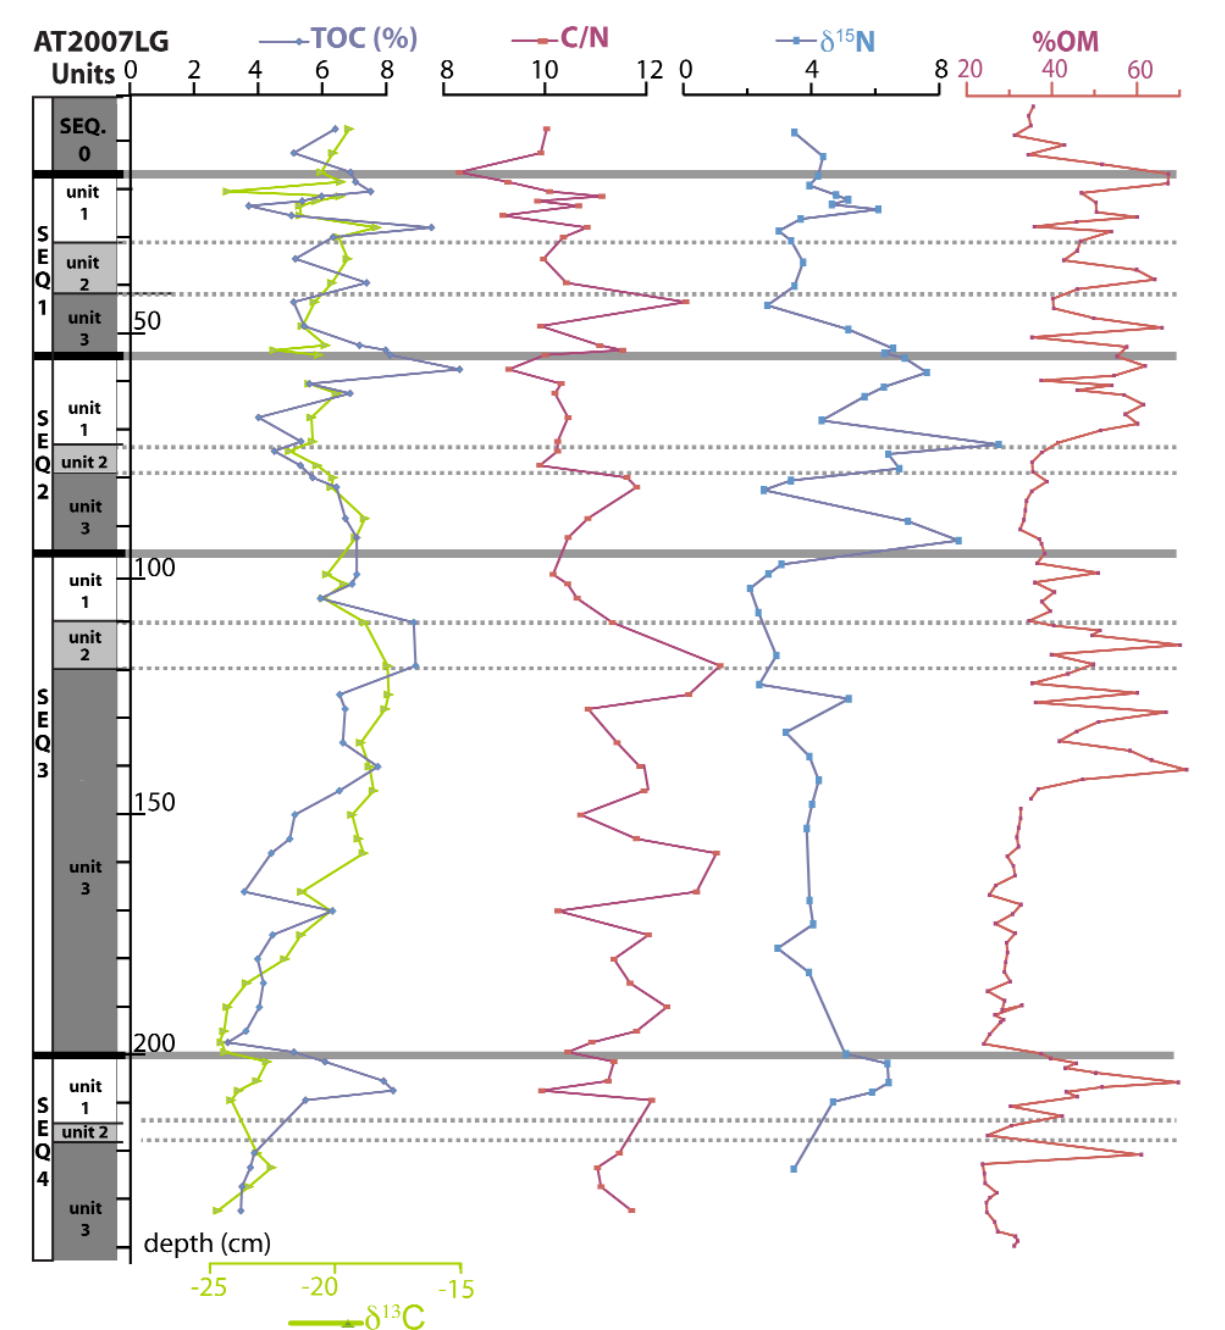
Figure 10. Analyses of the organic matter contained in the AT2007LG core combining LOI analysis (550 °C), d 13 C, TOC, C/N ratios and d 15 N measurements (from left to